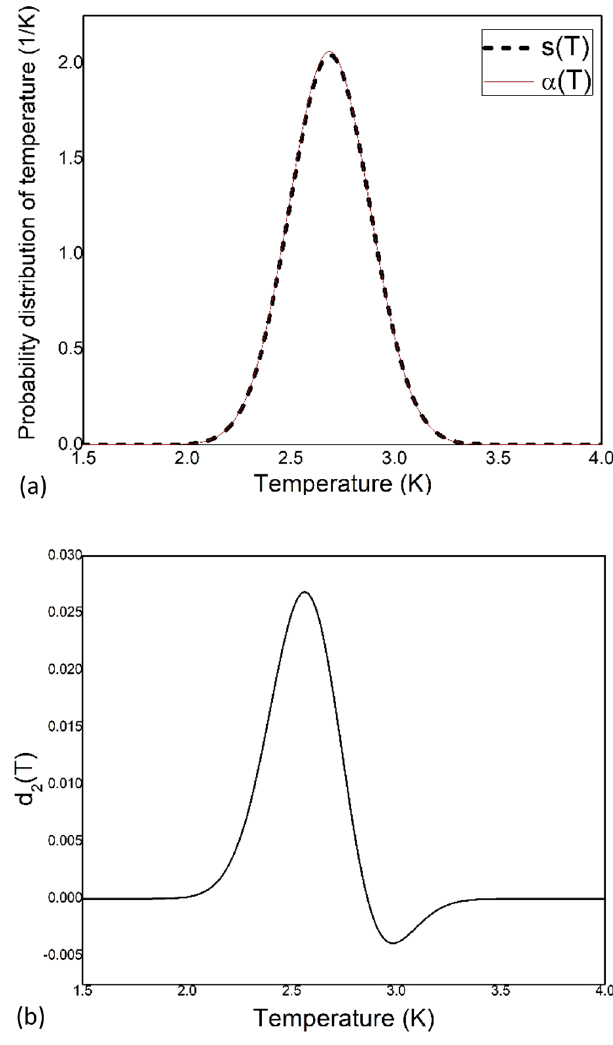
Figure 3. ( a ) The calculated temperature distribution α (T) and the Gaussian function s(T) are plotted against absolute temperature. ( b ) The difference between α (T) and s(T), expressed as d 2 (T) = α (T) – s(T) is plotted against absolute